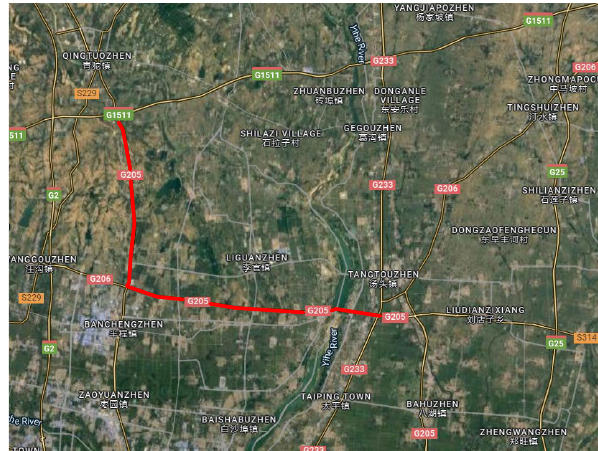
Figure 2. The locations for collecting pavement cracks.